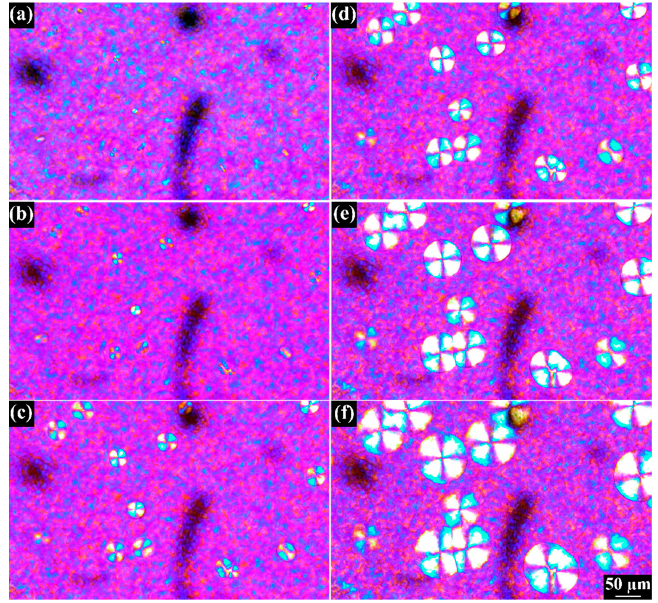
◦ C/min cooling rate